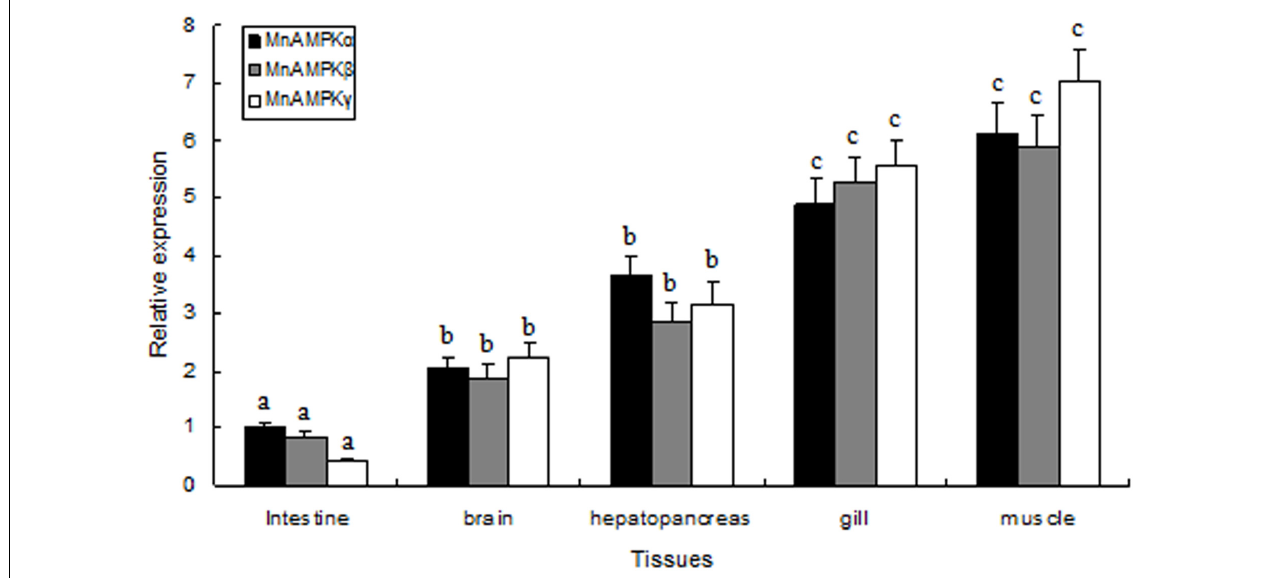
FIGURE 2 | Distribution of mRNA expression of the three AMPK subunits, α , β , and γ , in different tissues of M. nipponense , as assessed by real-time quantitative RT-PCR. MnAMPK α expression in intestine was used as a reference for relative expression. Values are expressed as the mean ± SE ( n = 9). Significant differences ( P < 0.05) among all tissues are indicated by different letters for each AMPK